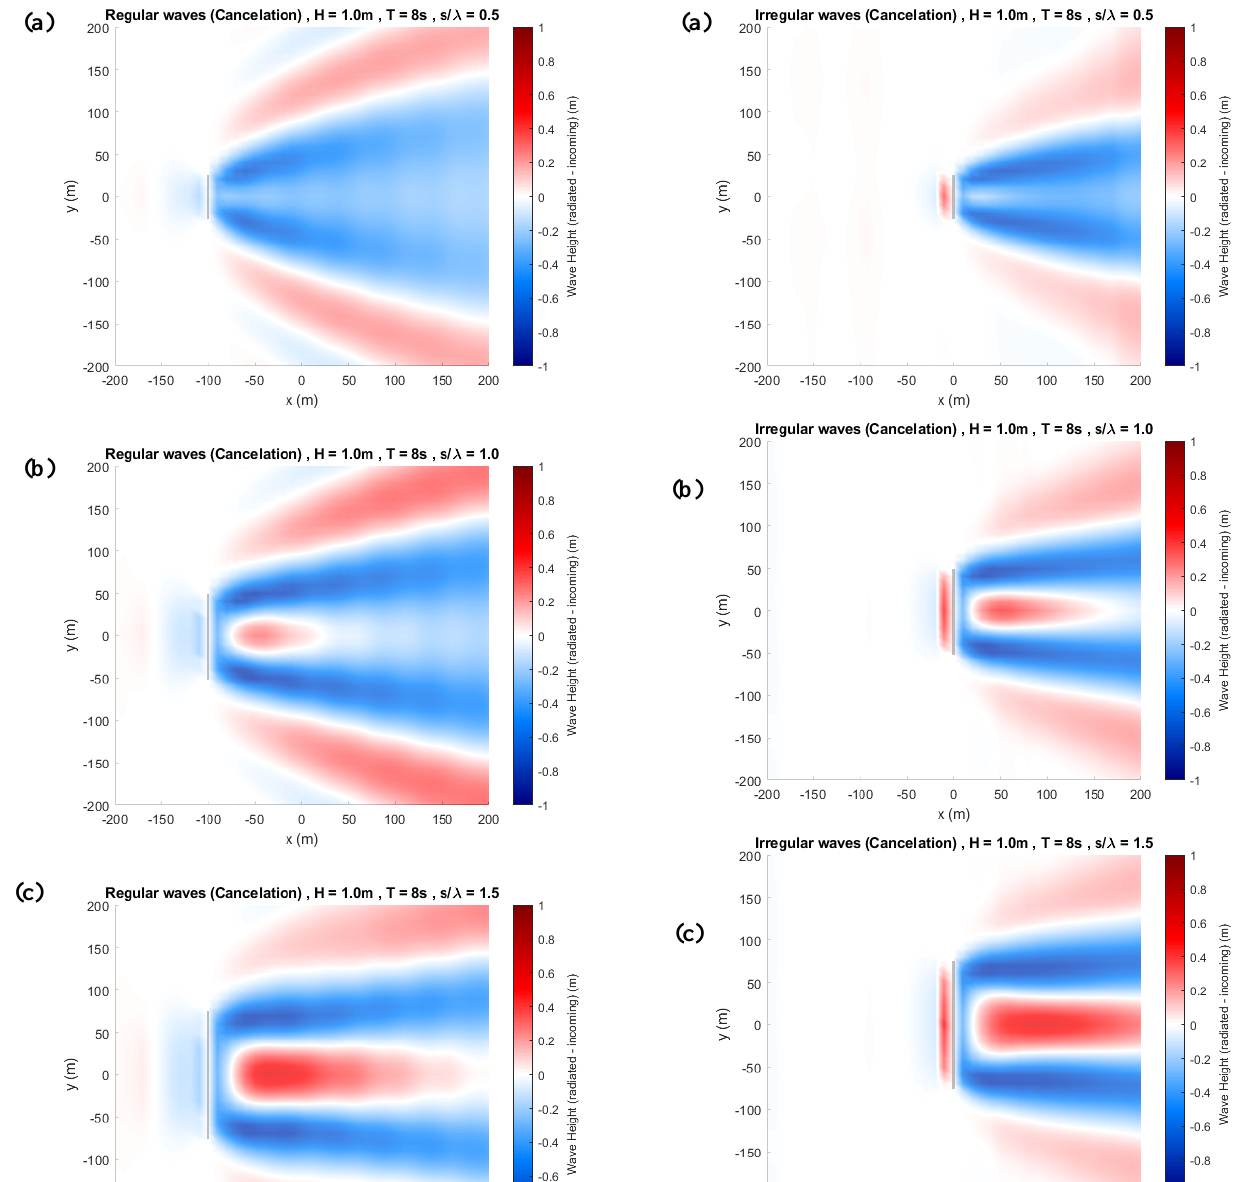
Figure 10: The significant wave height of the resulting (cancelation) wave field assuming irregular wave condition for different spans, (a) 𝑠 𝜆 ⁄ = 0.5 , (b) 𝑠 𝜆 ⁄ = 1.0 , and (c) 𝑠 𝜆 ⁄ =